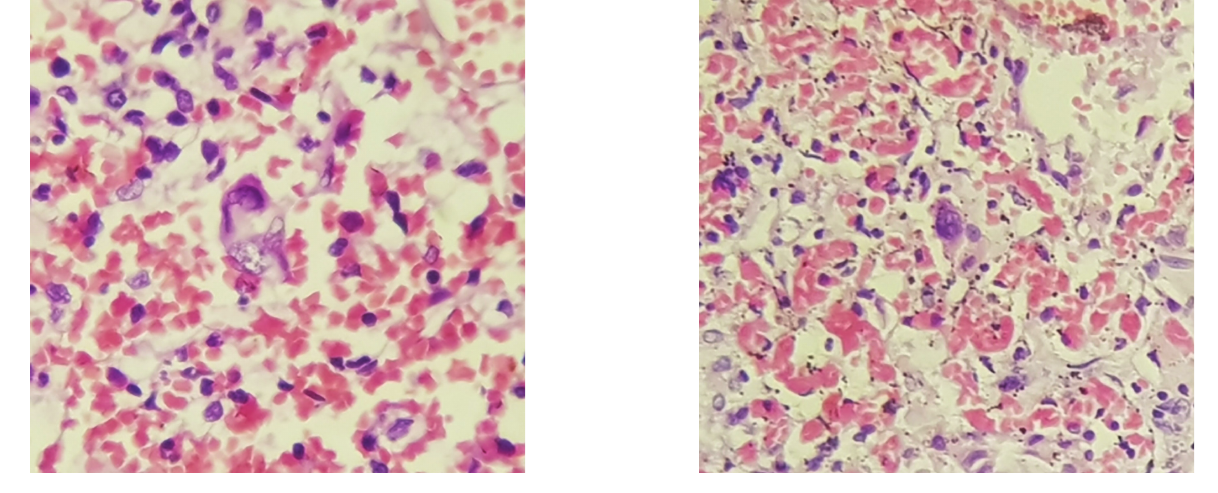
Figure 8a - Monster macrophages are multinucleated like giant cells. A, Multinucleated inclusions in the cytoplasm of autophages are clearly seen as monster